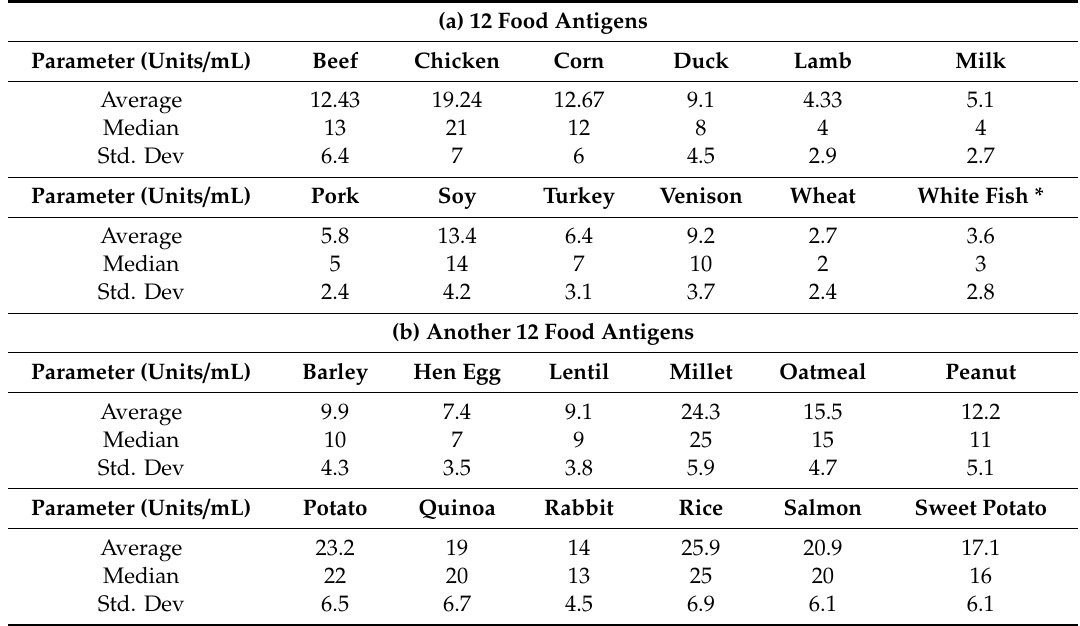
Table 3. Summaries of food reactivities in 1000 feline cases of proven or suspected bowel disorders.